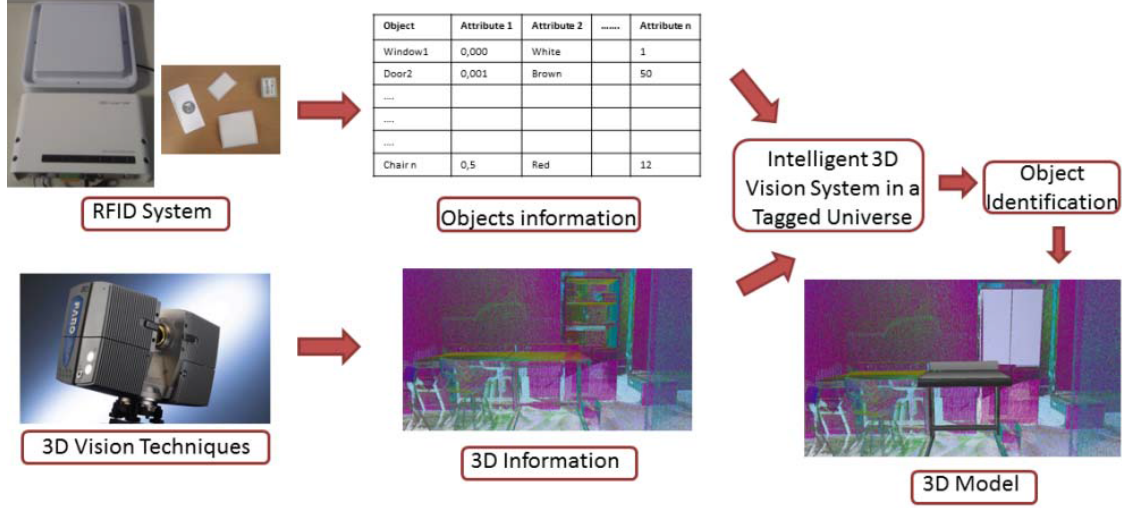
Figure 2. Overview of the system.